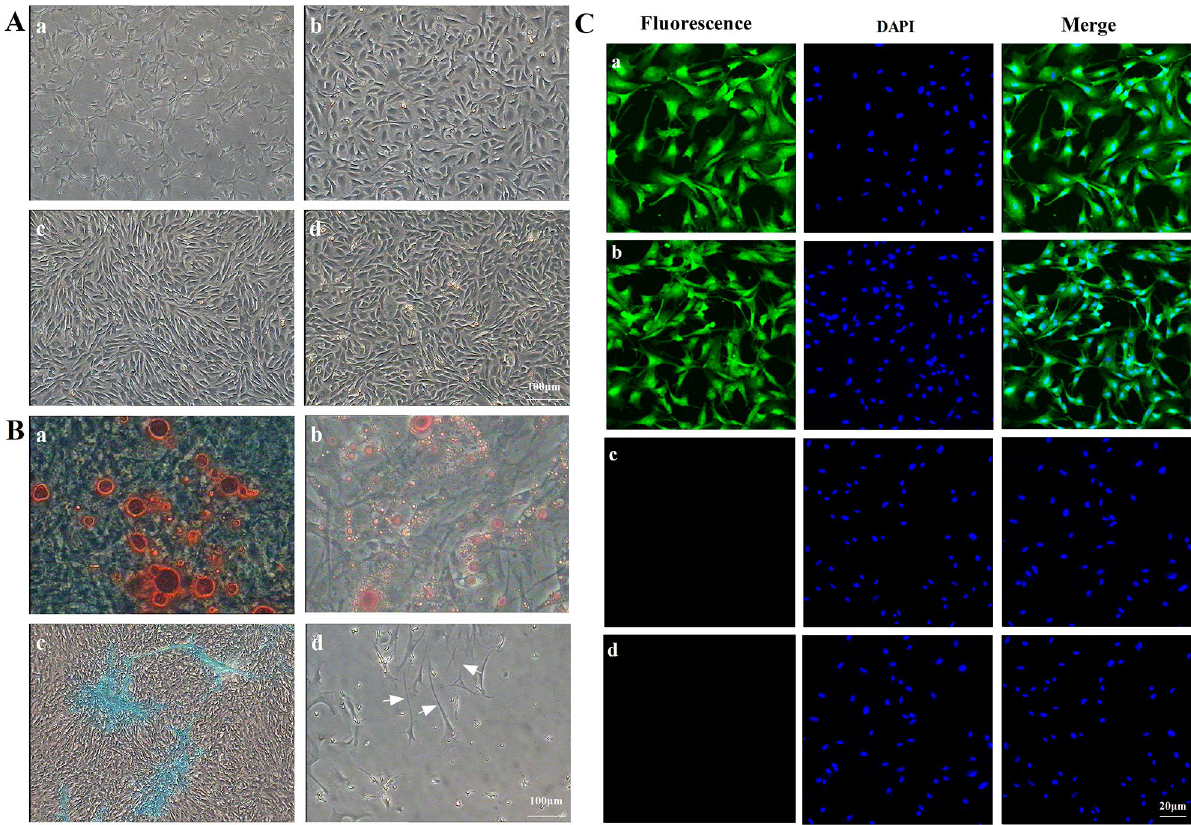
Figure 1. Biological characteristics of BM-MSCs. ( A ) The cellular morphology of chicken BM-MSCs was determined at different passages: P1 (a), P5 (b), P15 (c), and P25 (d). BM-MSCs were spindle-like cells. ( B ) Detection of the multilineage differentiation potential of BM-MSCs. Many calcium nodules appeared in the cytoplasm, and Alizarin red staining showed a positive reaction for calcified nodules in BM-MSCs that differentiated under osteogenic induction conditions for 21 days (a). Many lipid droplets formed in the cytoplasm of cells cultured under adipocytic induction conditions for 21 days and lipid droplets were successfully stained with Oil Red O (b). BM-MSCs were positive for Alcian blue staining after incubation with chondrogenic medium for 21 days (c). The cellular morphology changed from a spindle-shaped morphology to a multipolar and stellate morphology, and the BM-MSCs grew many branches and formed many synapses (white arrows) on the cell surface after culture under neurogenic induction conditions for 21 days (d). ( C ) The results of immunofluorescence staining. High expression of Nestin (a) and MAP-2 (b), markers of neural cells, was detected in differentiated BM-MSCs, while Nestin (c) and MAP-2 (d) were not detected in undifferentiated BM-MSCs. ( A and B , ×40 magnification. C , ×200 BM-MSCs administration relieved pulmonary edema. LPS injection prominently upregulated total protein concentration (Fig. 5A; P < 0.01) and W/D ratio (Fig. 5B; P < 0.01) compared to Sham. BM-MSCs treat- ment exerted a prominent preventative effect on the increases in total protein concentration ( P < 0.05) and the W/D ratio ( P < 0.05), demonstrating that BM-MSCs administration reduced the degree of pulmonary edema. As shown in Supplementary Material 4, LPS injection increased the Evans blue content in lung tissue compared to Sham ( P < 0.01). BM-MSCs treatment attenuated the Evans blue content in lung tissue compared to LPS ( P < 0.01). BM-MSCs administration reduced pulmonary inflammation. LPS administration markedly increased CXCL-1 (Fig. 6A; P < 0.01), IL-1β (Fig. 6C; P < 0.01), IL-8 (Fig. 6D; P < 0.01), and TNF-α (Fig. 6J; P < 0.01) mRNA expression and markedly decreased IL-1RN (Fig. 6B; P < 0.01) and IL-10 (Fig. 6E; P < 0.01) mRNA expression in lung tissue. BM-MSCs administration markedly increased IL-1RN ( P < 0.01) and IL-10 ( P < 0.01) mRNA expression and markedly decreased CXCL-1 ( P < 0.01), IL-1β ( P < 0.01), IL-8 ( P < 0.05), and TNF-α ( P < 0.01) mRNA expression in lung tissue. As shown in Table 2, LPS injection markedly upregulated BALF levels of CXCL-1 ( P < 0.01), IL-6 ( P < 0.01), IL-8 ( P < 0.01), IL-10 ( P < 0.01), and TNF-α ( P < 0.01) and markedly downregulated BALF levels of IL-1RN ( P < 0.01). BM-MSCs administration increased IL-10 ( P < 0.01) and IL-1RN ( P < 0.05) release and impaired